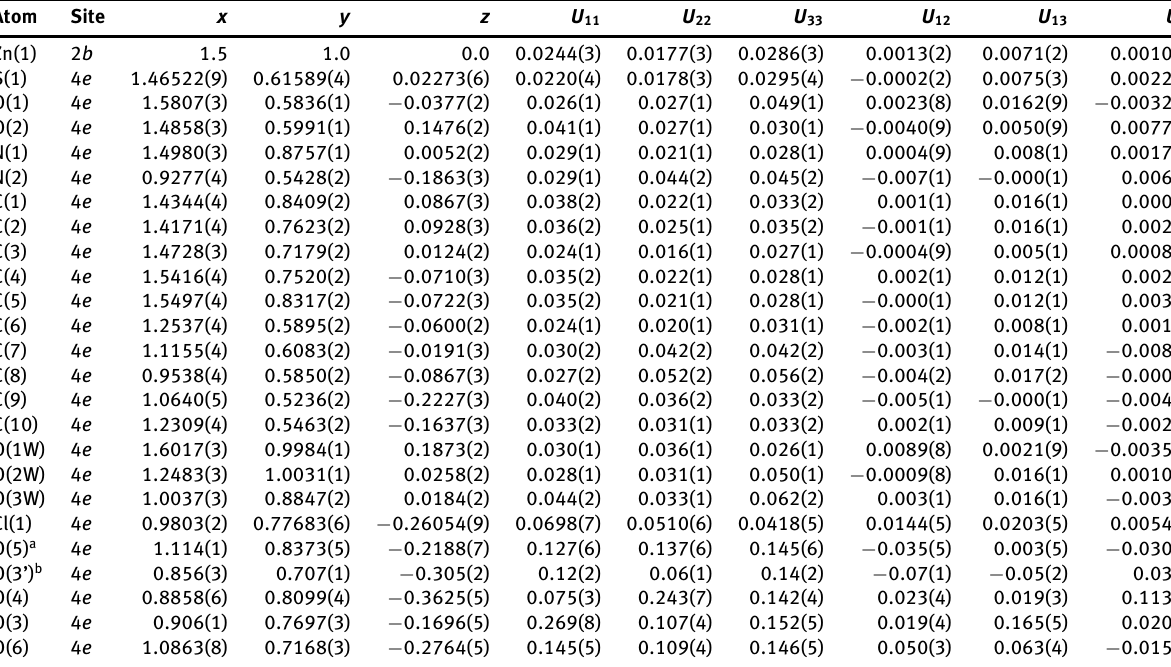
Table 3: Atomic displacement parameters (Å 2